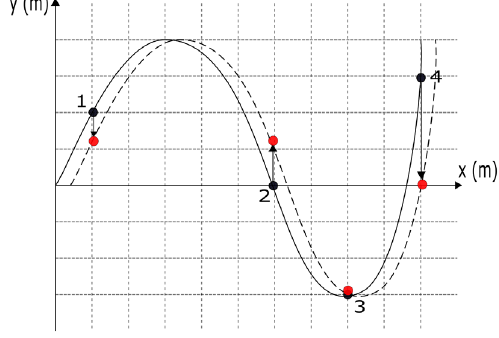
FIG. 2. A graph of two wave profiles at two instants.